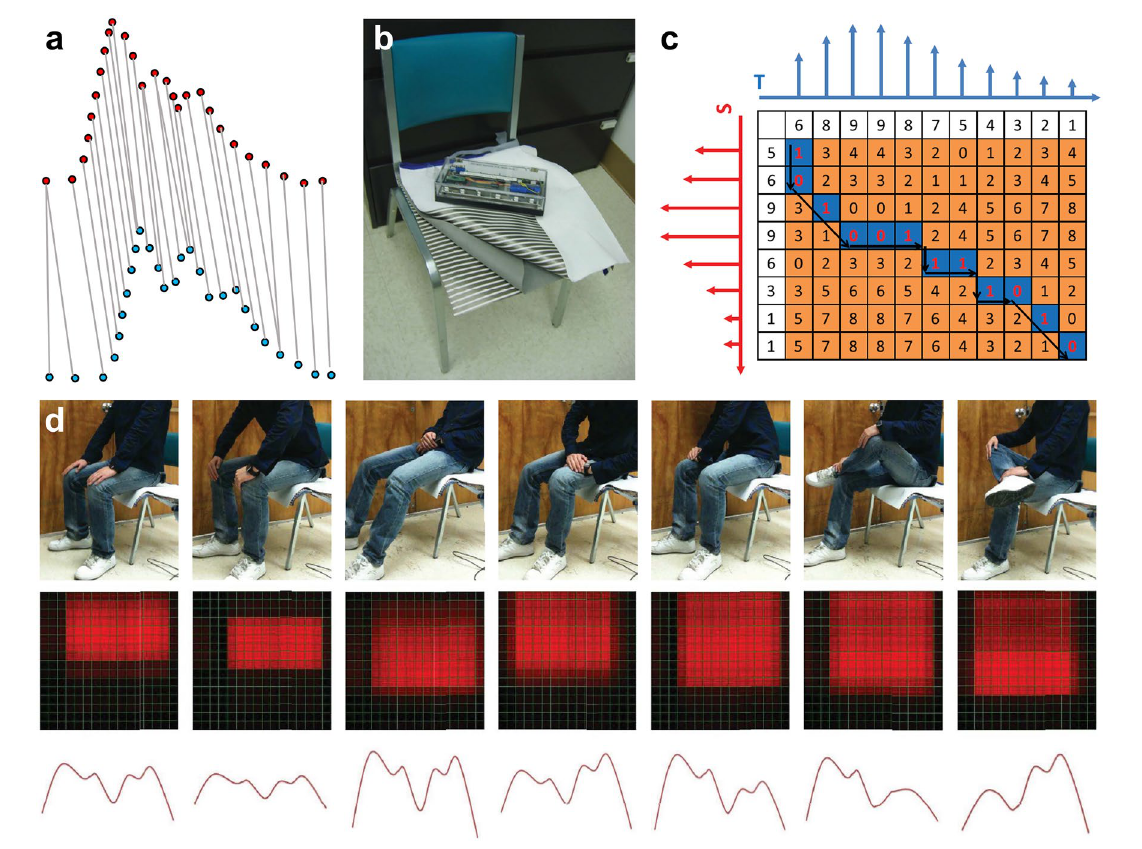
Fig. 20 Signals detected by the soft system and processed by DTW. a Schematic diagram of DTW. b Photograph of Smart Cushion with textile sensor array. c A DTW example of two pressure profile sequences. d Sitting posture analysis: seven sitting postures (top) are evaluated and each eTextile pressure map (middle) is transformed to a corresponding pressure profile sequence (bottom). Reproduced with permission [315]. Copy- right (2013), Institute of Electrical and Electronics